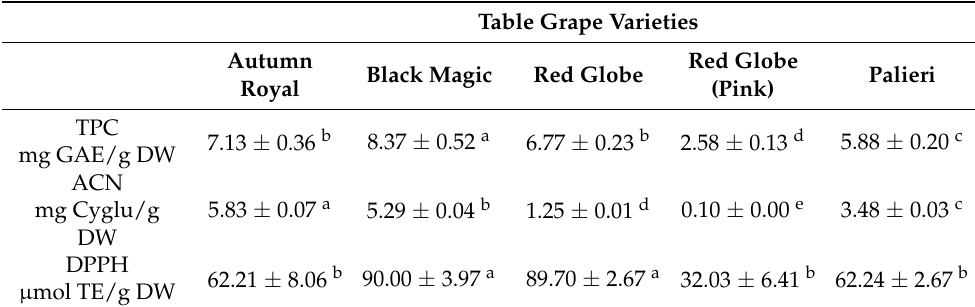
Table 2. Total polyphenol content (TPC), total anthocyanin content (ACN), and the antioxidant activity (measured by DPPH assay) of table grape skins.